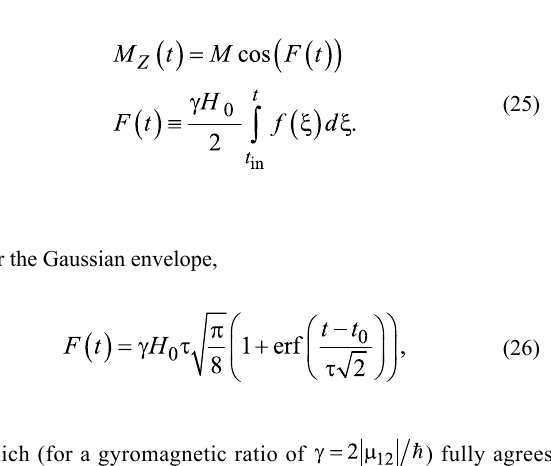
Figure 4: Dependence of the optimal magnetic field value versus the external magnetic pulse duration, T, for (a) the atomic-based qubit in an oscillating magnetic field (µ 12 = 10µ 0 , ω l = ω 12 ≈ 2·10 13 Hz, t 0 = 3 τ , T = 6 τ ); (b) the superconducting flux qubit (µ 12 = 10 6 µ 0, ω 12 ≈ 10 10 Hz) under the influence of unipolar impact with a Gaussian ( ω l = 0, t 0 = 3 τ , T = 6 τ ) and rectangular (T = τ ) envelope; (c) the superconducting qubit interacting with the passing fluxon. The filled circles are the numerical calculations and the solid lines are the analytical approaches described using Equations 20–23. The squares represent the fluxon speed providing appropriate duration of impact for the region of qubit–fluxon interaction of 0.5 μ